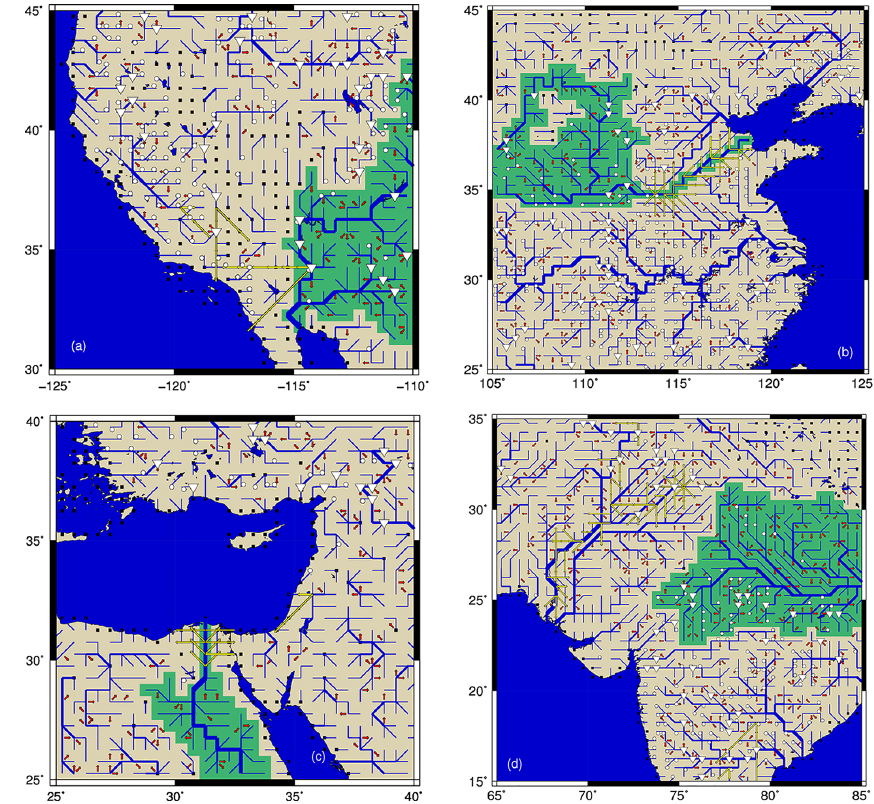
Figure 4. River systems of (a) the western United States, (b) central China, (c) the eastern Mediterranean region, and (d) the Indian subconti- nent. Blue lines are the digital river network of DDM30 (Döll et al., 2002). Open inverse triangles are global reservoirs or the reservoirs listed in GRanD (Lehner et al., 2011) with a catchment area larger than 5000km 2 . Open circles are local reservoirs or the reservoirs with a catch- ment area not larger than 5000km 2 . Yellow and red arrows are explicit and implicit aqueducts. For reference, the extent of the Colorado, the Yellow, the Nile, and the Ganges river basins are shown in green.